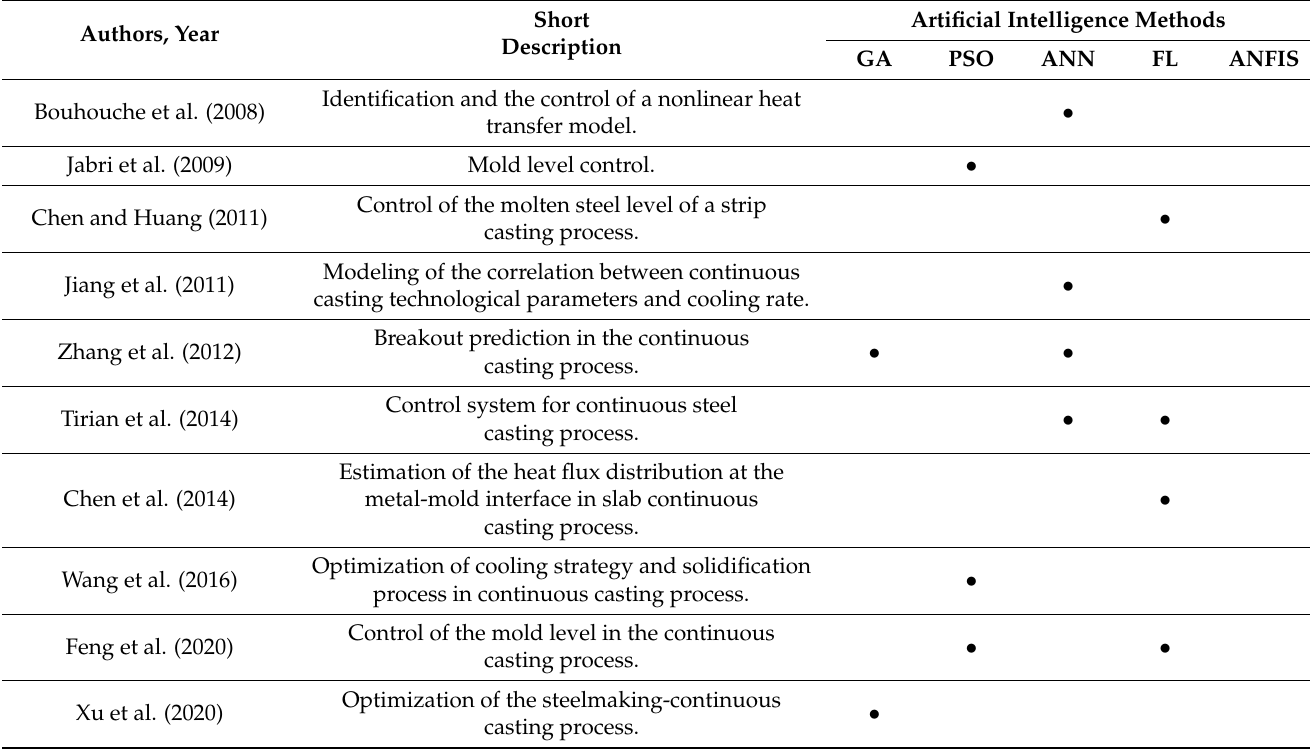
Table 3. Artificial intelligence methods used for the improvement of the continuous casting